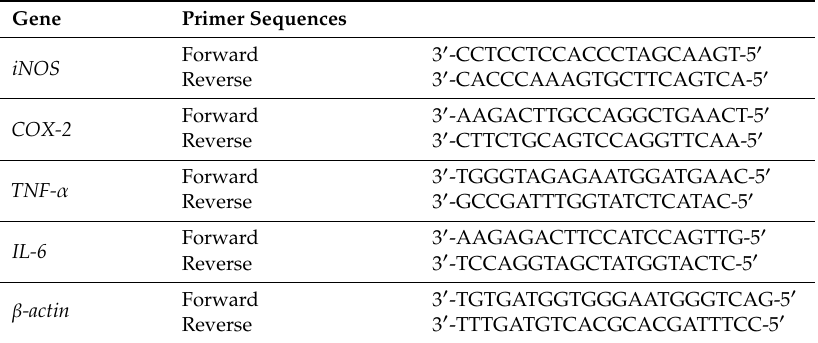
Table 1. Primer sequences for reverse transcription-polymerase chain